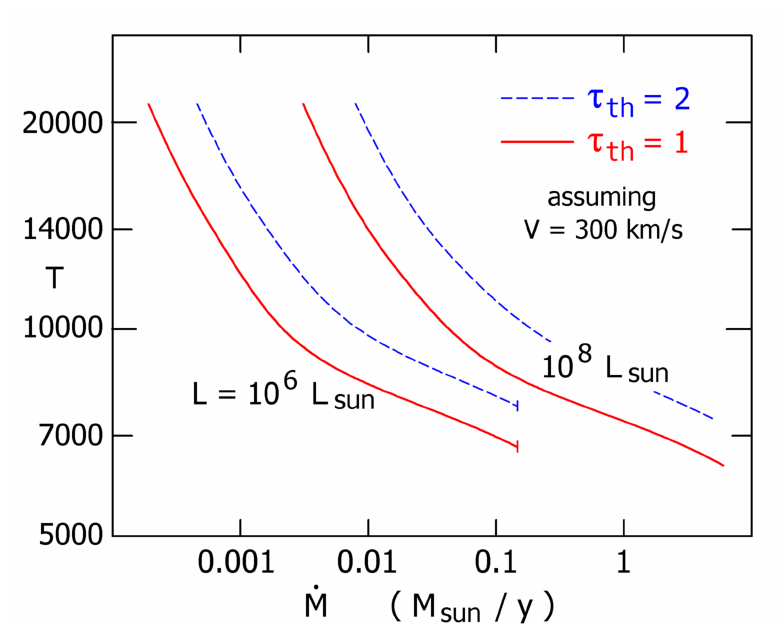
Figure 4. Photosphere temperatures in simplified opaque outflow models with L = 10 6 and 10 8 L (cid:12) and V = 300 km s − 1 . The curves show temperatures corresponding to thermalization depths of 1 and 2. T ( τ th ) depends approximately on the quantity ˙ MV − 1 L − 0.67 . Temperature values here are imprecise and very likely overestimated, because the models are highly idealized; see text.